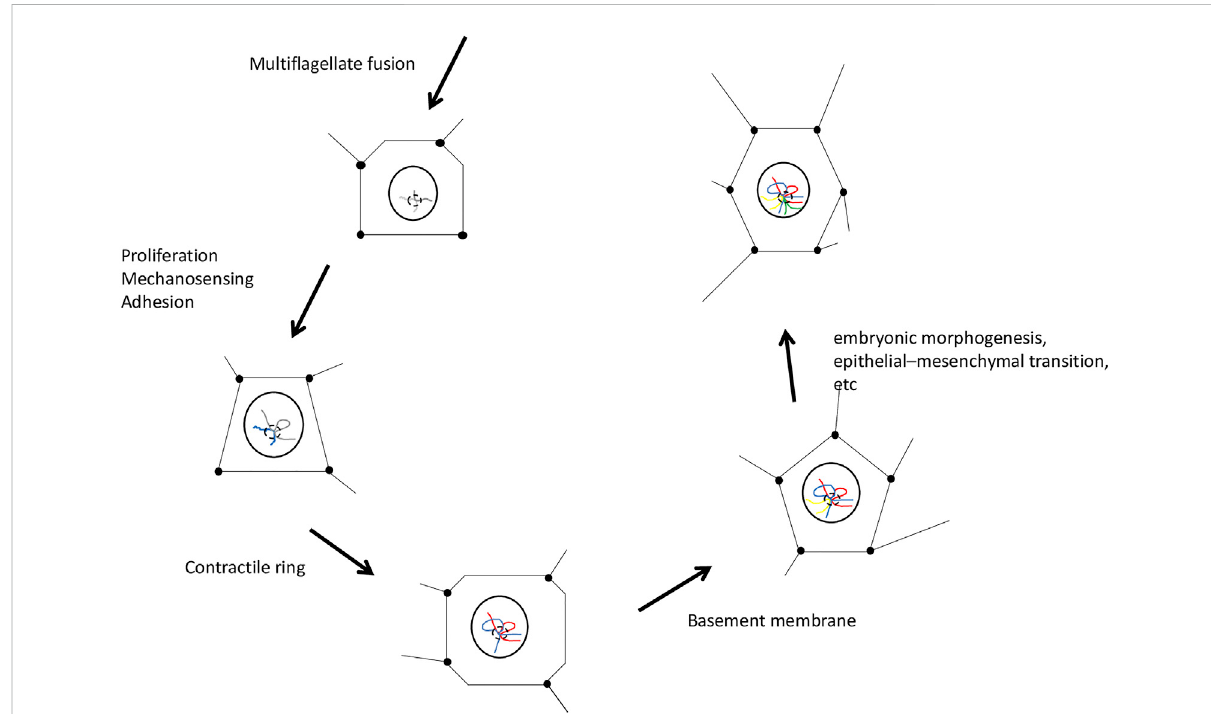
FIGURE 1 General scheme of the neoplastic functional module. Chromosomal domains were associated topologically by the physical impact of embryo construction. The projected points and lines of the geometric fi gures represent the impact of embryonic morphogenesis on the cell nucleus. The cells depicted in the fi gure are multipotent cells that receive most of the biophysical impact promoting embryo patterning. Neoplasia is the driving force of embryo formation. The disease cancer is imbued inembryo construction and masked byits organization. The last cell of thescheme is one of the 2 cells of the hermaphroditic germ line of the fi rst embryo, which harbors the neoplastic functional module and mechanical memory, elements that contribute to the reconstruction of the process in the following generation. Emergence of animal phylogeny, cancer, and the fi rst embryo is implicit in the events represented in this